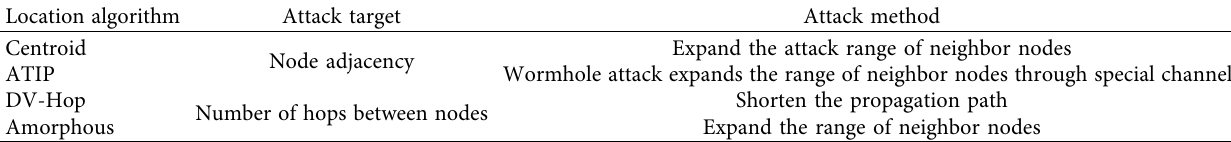
Table 2: Attack methods for location algorithm without ranging.